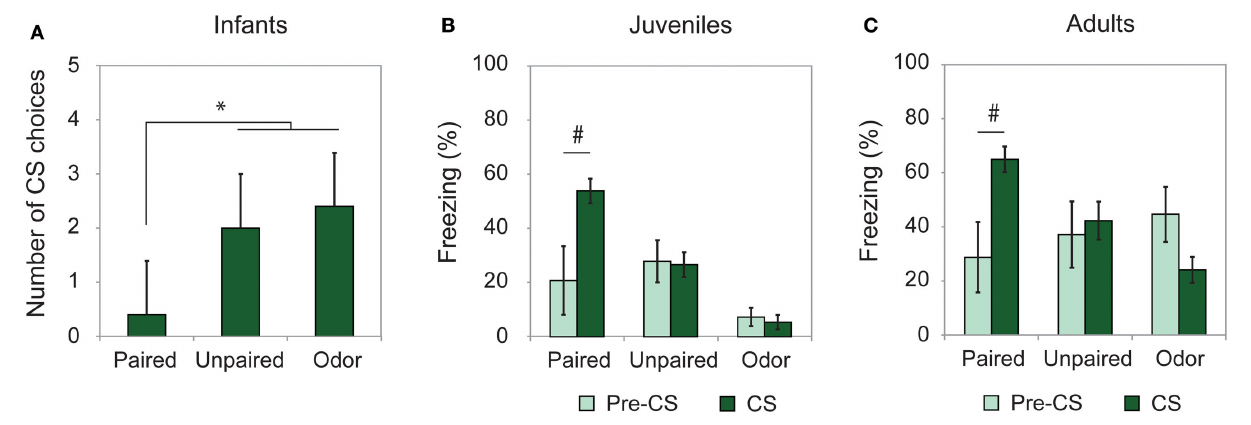
Unpaired, n = 9; Odor, n = 6) and (C) adults (Paired, n = 8; Unpaired, n = 8; Odor, n = 10) received a cue test in a novel environment and the freezing rate (mean ± s.e.m.) was compared between pre-CS and CS Odor. # Significant intragroup difference ( p < 0 . 05); ∗ significant intergroup difference ( p < 0 .